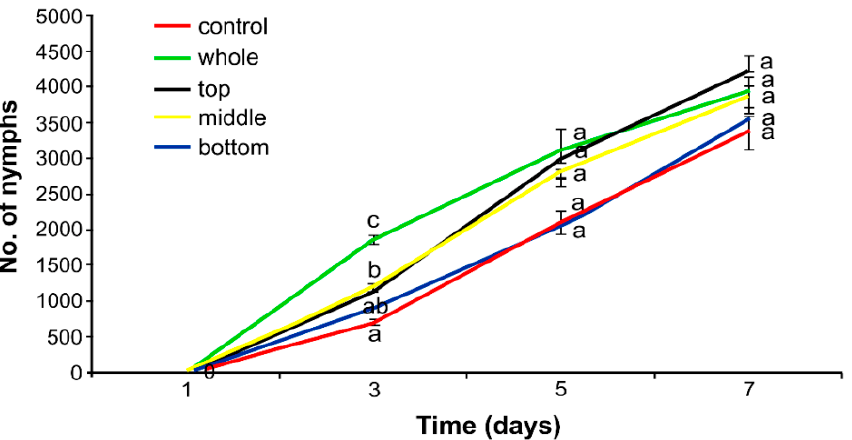
Figure 3. Cumulative increase in the number of hemp aphid ( Phorodon cannabis ) on hemp ( Cannabis sativa ) plants after application of Pantera 040 EC graminicide to different sections of the plant (mean ± SE; control = water). Values not followed by the same letter are significantly different at the level of p < 0.05 (Tukey multiple range test).